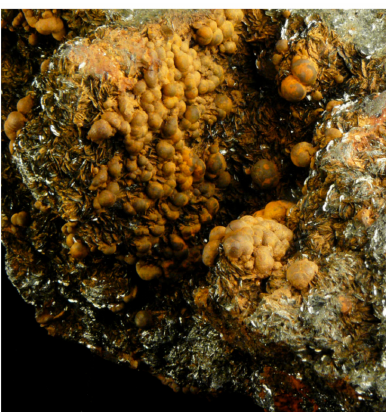
Figure 20. Goethite spherules and hematite, Toothaker Creek prospect. 21 cm. Chamberlain Collection, NYSM 12542. SC.